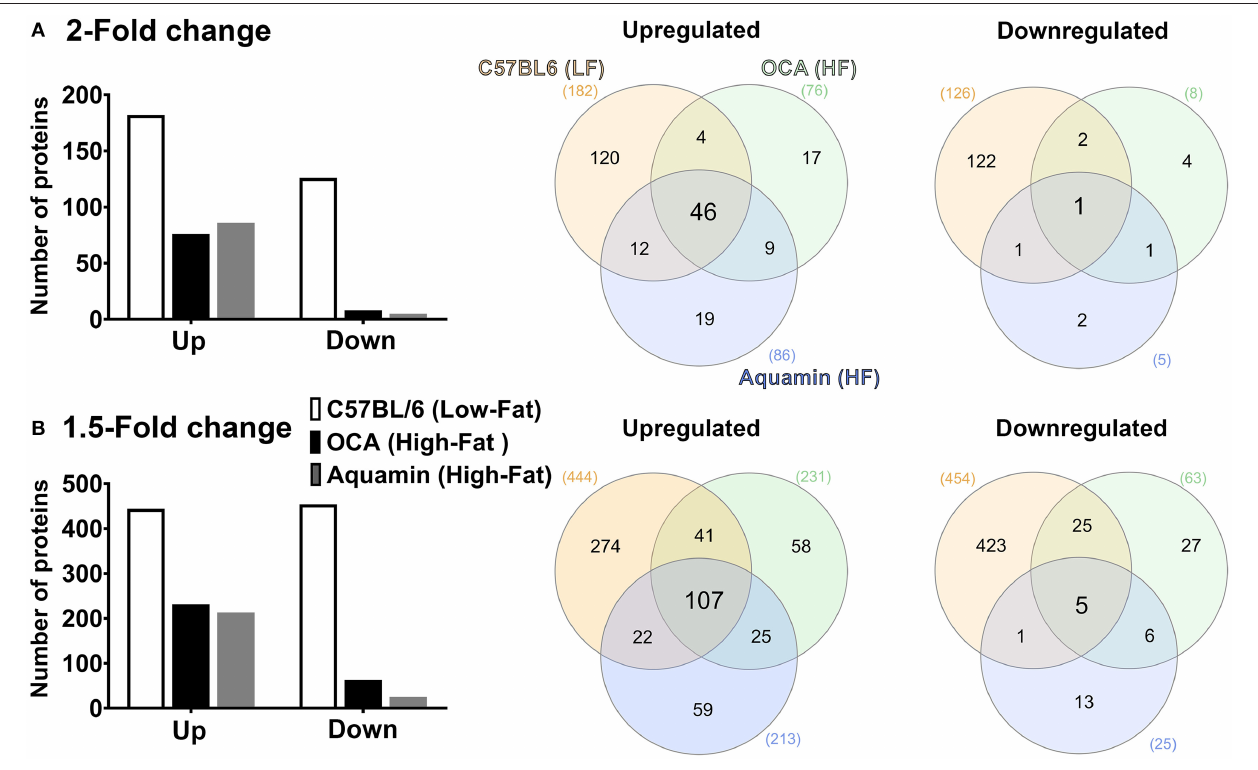
FIGURE 3 | Proteomic analysis. Lysates were prepared from liver tissue of individual mice (five per group) and subjected to Tandem Mass Tag (TMT) labeling / mass spectroscopy as described in the Materials and Methods Section. Data from individual animals were merged by treatment group for analysis. Left panels: Abundance ratios of all proteins were calculated by comparing the normalized abundance of each group to the high-fat control group. The upper panel indicates the number of proteins that were increased or decreased by 2-fold (A) or greater (with ≤ 2% FDR) and the lower panel indicates the number of proteins that were increased or decreased by 1.5-fold (B) or greater (with ≤ 2% FDR). Right panels: Venn diagrams showing the overlap in the number of proteins altered (increased or decreased) by an average of 2-fold (A) or greater (upper panel) or 1.5-fold (B) or greater (lower panel) among the three treatment groups relative to the high-fat control and unique to each